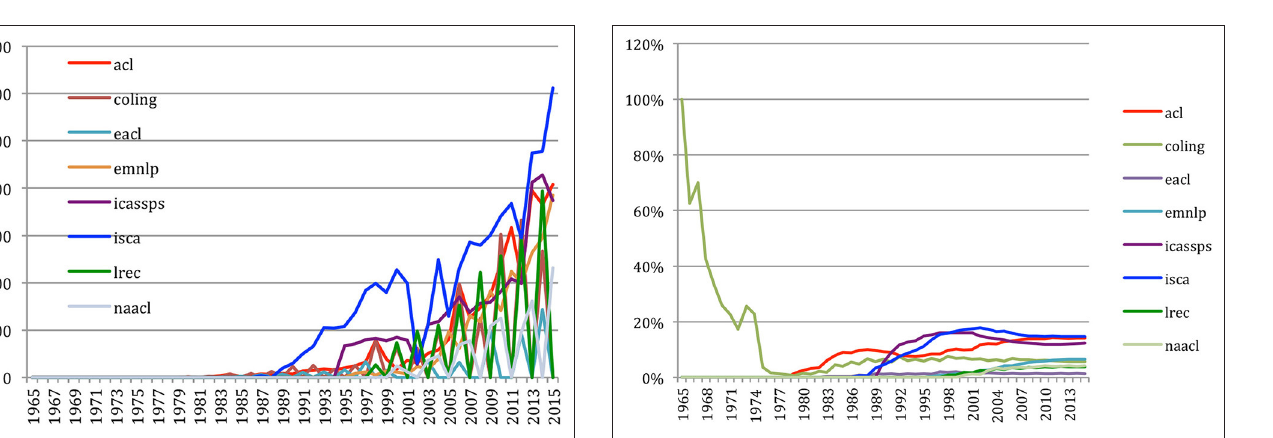
FIGURE 41 | Percentage of the papers that have been cited over the years for the eight most important conferences.